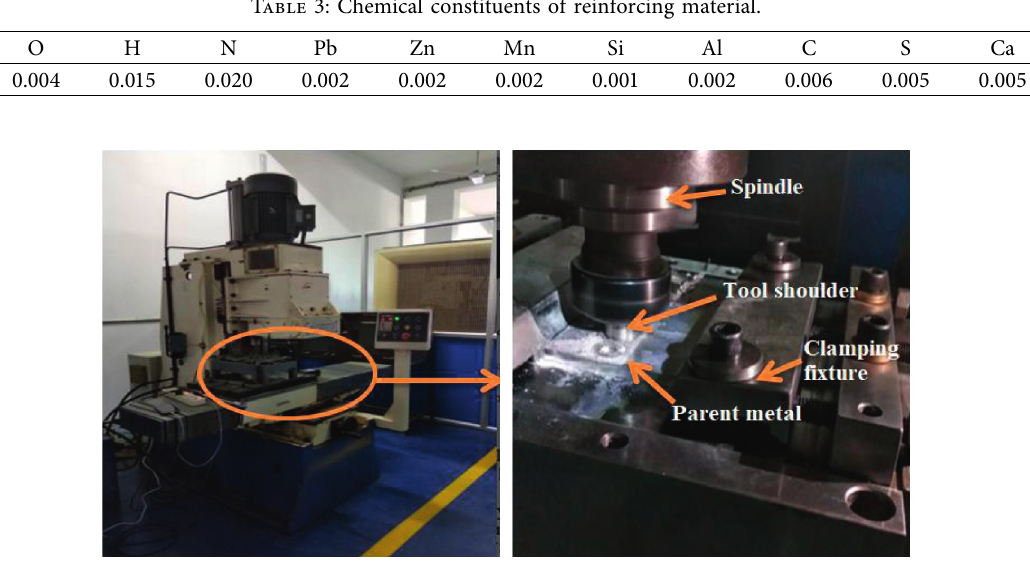
Figure 2: FSW experimental